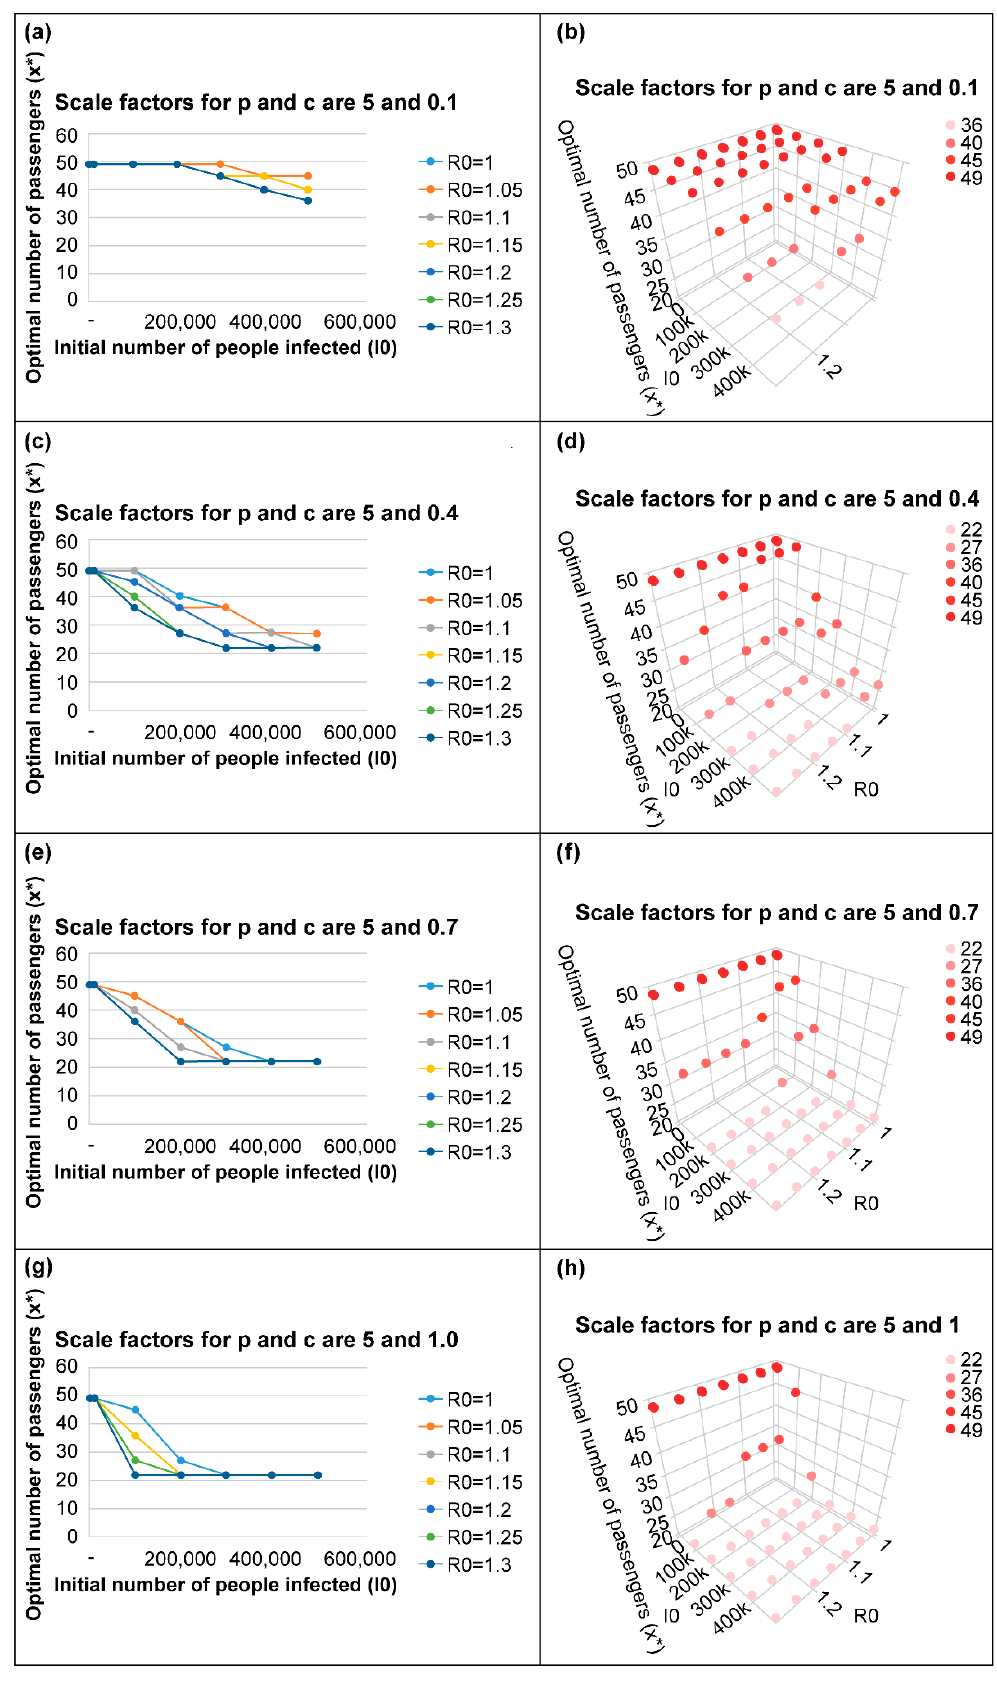
Figure 4. Optimal number of passengers to minimize total social cost when the scale factor for p is 5.